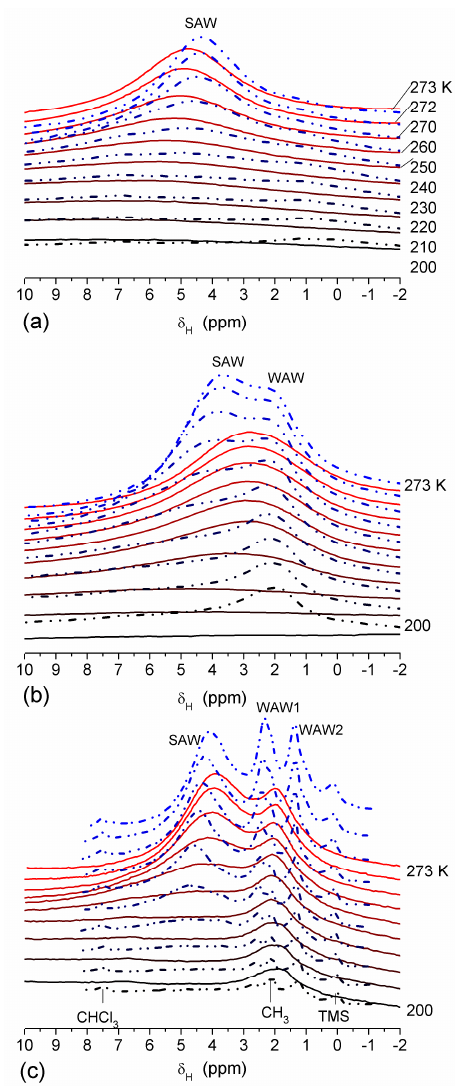
Figure 15. 1 H NMR spectra of water bound to ( a – c ) CM1 and ( c ) CM2 (dot-dashed lines) at hydration h = 2.3 wt % in different media: ( a ) air (solid lines) CDCl 3 (dot-dashed lines), ( b ) CD 3 CN (solid lines) CD 3 CN:CDCl 3 = 1:2.6 (dot-dashed lines), ( c ) CD 3 CN:CDCl 3 = 1:5.